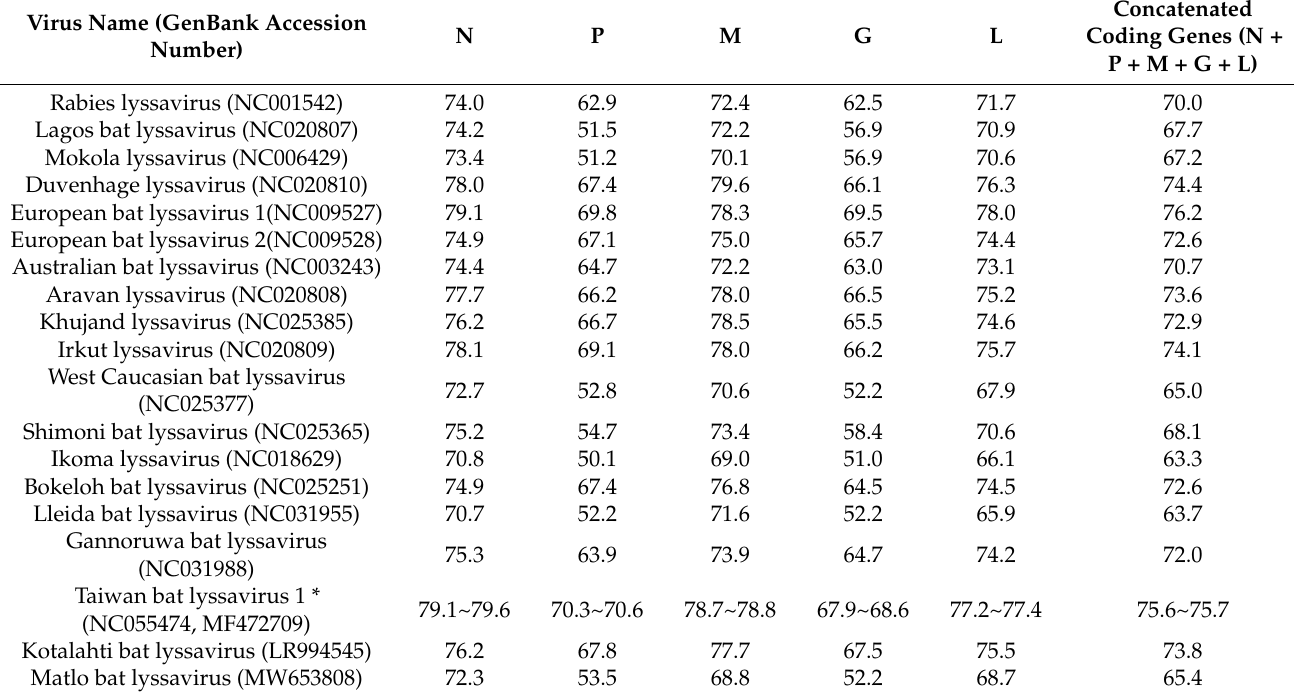
Table 2. The nucleotide identities (%) for the nucleoprotein (N), phosphoprotein (P), matrix protein